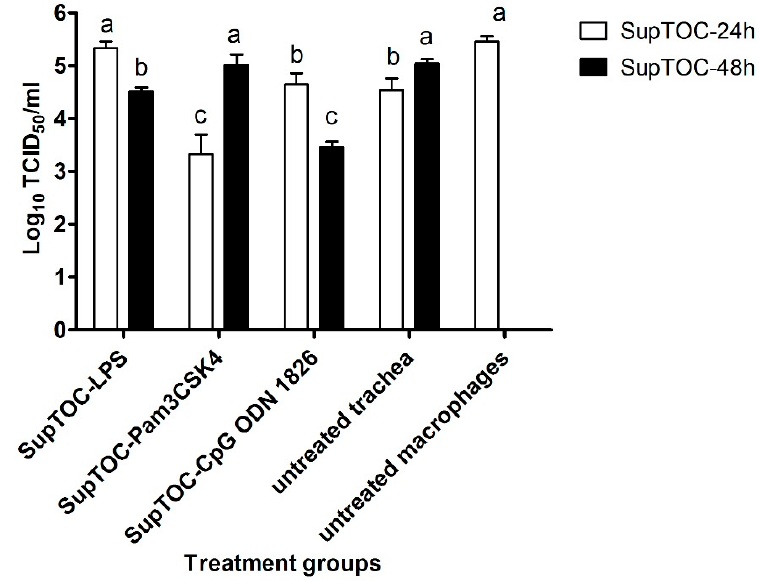
Figure 4. Supernatants from TOCs stimulated with TLR ligands reduced influenza virus replication in chicken macrophage cells. There were five groups. Three of them were treated with supernatants from TOCs treated with LPS from E. coli O26:B6, Pam3CSK4 and CpG ODN 1826 and one was treated with supernatant from TOCs that received only medium (untreated trachea), and the last group did not receive supernatant from TOCs. Cells were infected 6 h later with H4N6 avian influenza virus (MOI of 1.0). Virus titer (12 h after infection) was quantified by means of a TCID 50 assay. a–c columns with no common letter are significantly different ( p ≤ 0.05). SupTOC ‐ 24h: culture supernatants from TOCs collected 24 h post ‐ treatment with TLR ligands or medium. SupTOC ‐ 48h: culture supernatants from TOCs collected 48 h post ‐ treatment with TLR ligands or medium .